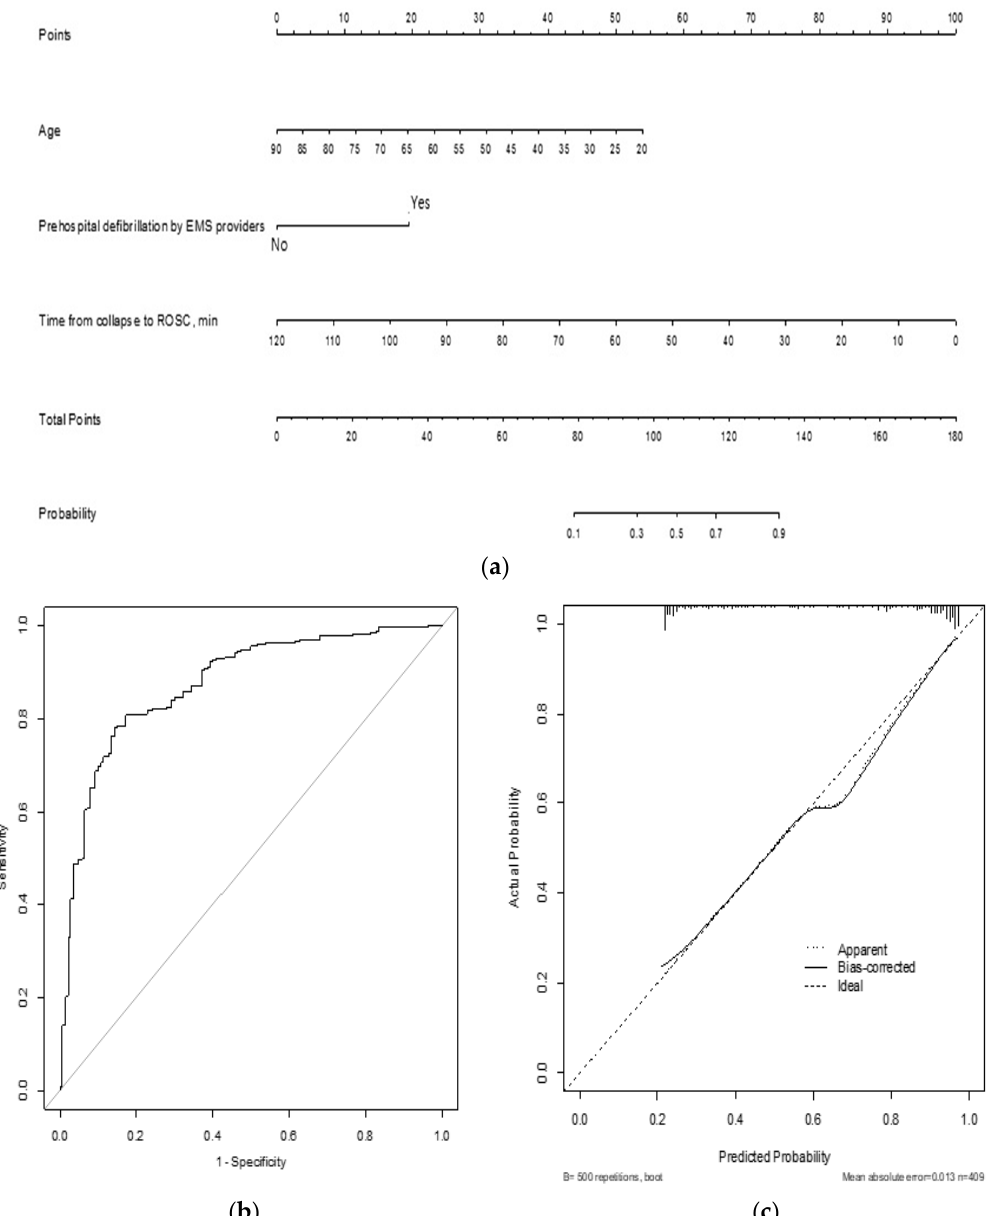
Figure 3. Nomogram for predicting good neurologic outcomes. ( a ) The novel nomogram for predicting good neurologic outcomes developed using the training data set is shown. ( b ) The discriminative ability of the nomogram is good, with an area under the curve of 0.8742 (95% confidence interval: 0.8383–0.9101). ( c ) The calibration plot of the prediction model indicates good agreement between the predicted and observed probabilities of good neurologic outcomes. Abbreviations: EMS: emergency medical service, ROSC: return of spontaneous circulation.